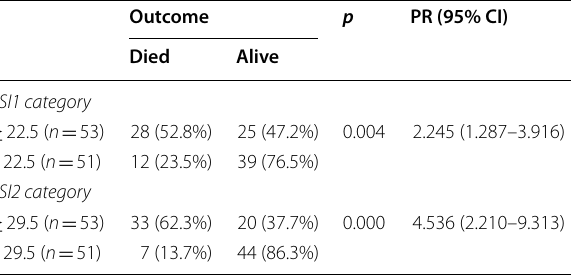
Table 3 Cross-tabulation RSI1 and RSI2 categories to